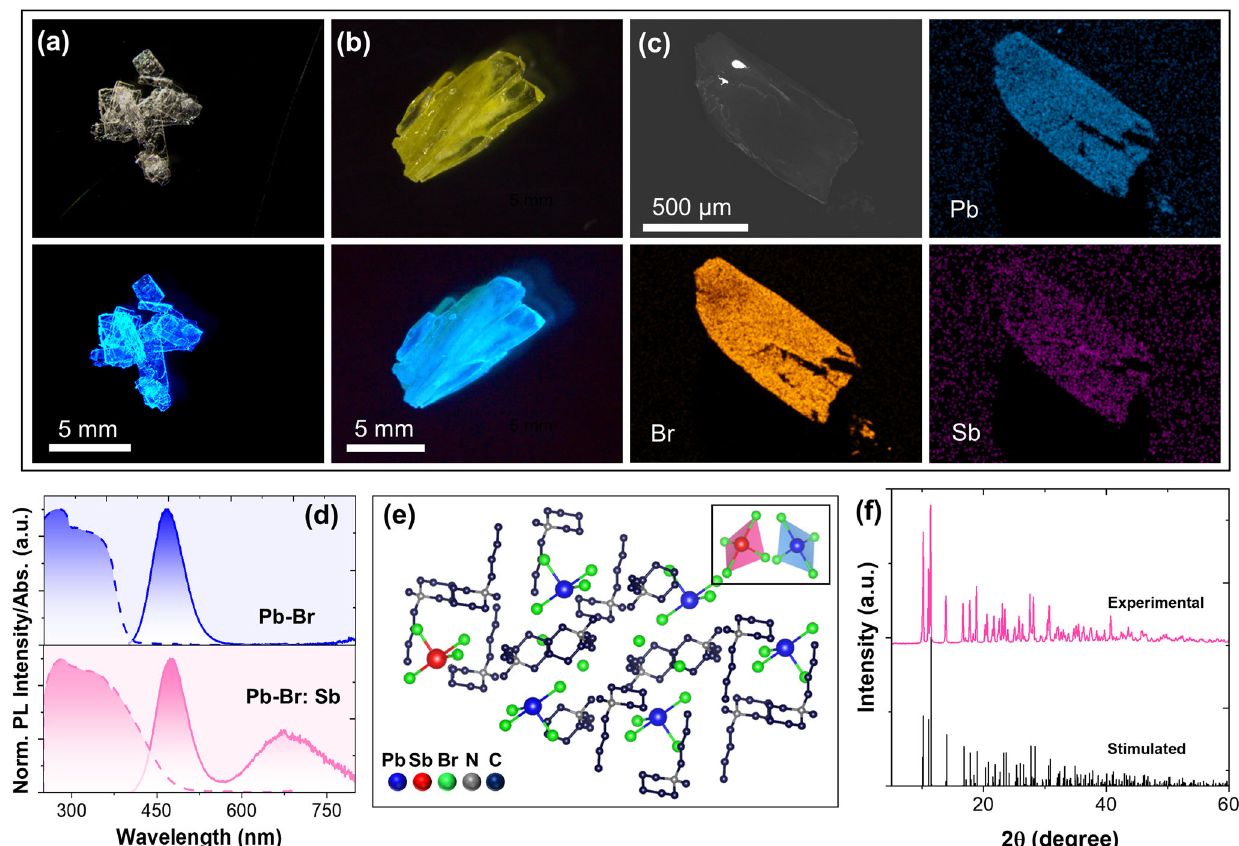
Fig. 1 Crystal structure and optical properties characterization. Optical images of Pb-Br ( a ) and Pb-Br: Sb ( b ) single crystals under daylight (top) and 365 nm UV light (bottom). c SEM image and elements mapping of Pb, Br and Sb in Pb-Br: Sb single crystal. d Normalized UV-vis absorption spectra (dotted line) and PL emission spectra (solid line) of Pb-Br and Pb-Br: Sb. e Schematic view of Pb-Br: Sb crystal structure, inset showing seesaw-shaped PbBr 42 − and SbBr 4 − units. f Comparison of experimental and stimulated powder XRD patterns of Pb-Br: